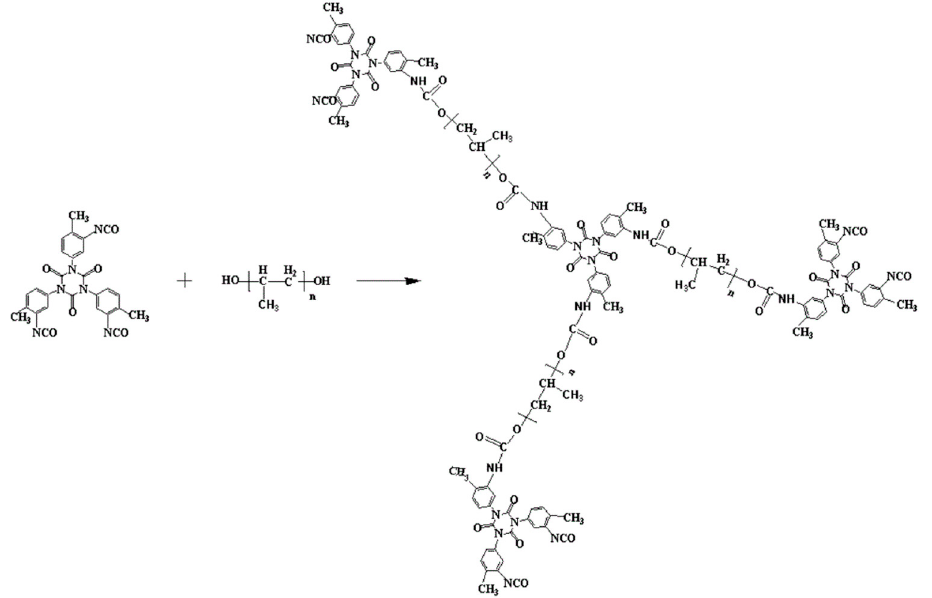
Scheme 1. Synthesis of the prepolymer by reaction of the trimer with polyol (PUP).